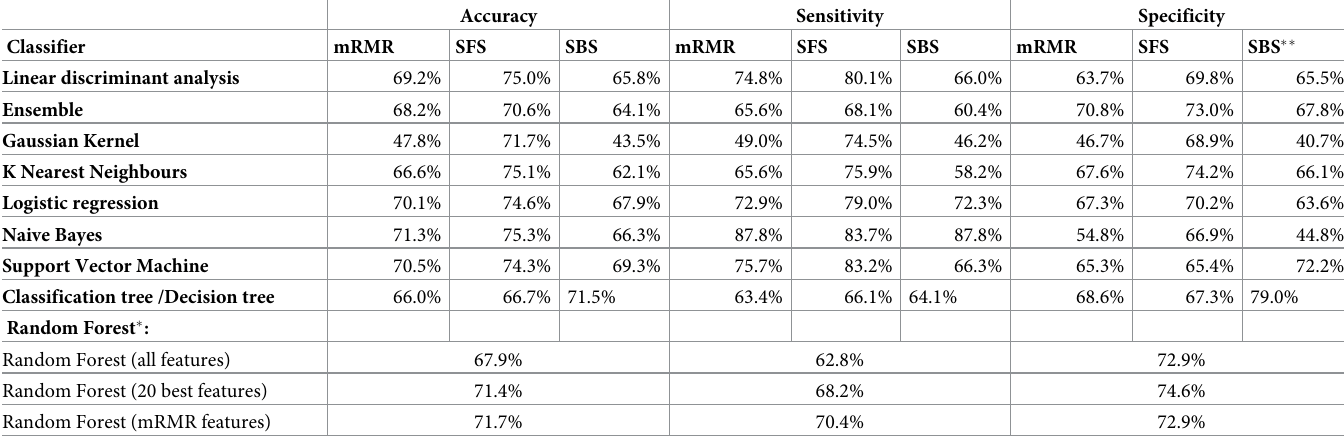
Table 4. Classification of individual steps with nine classifiers and three feature selection methods.